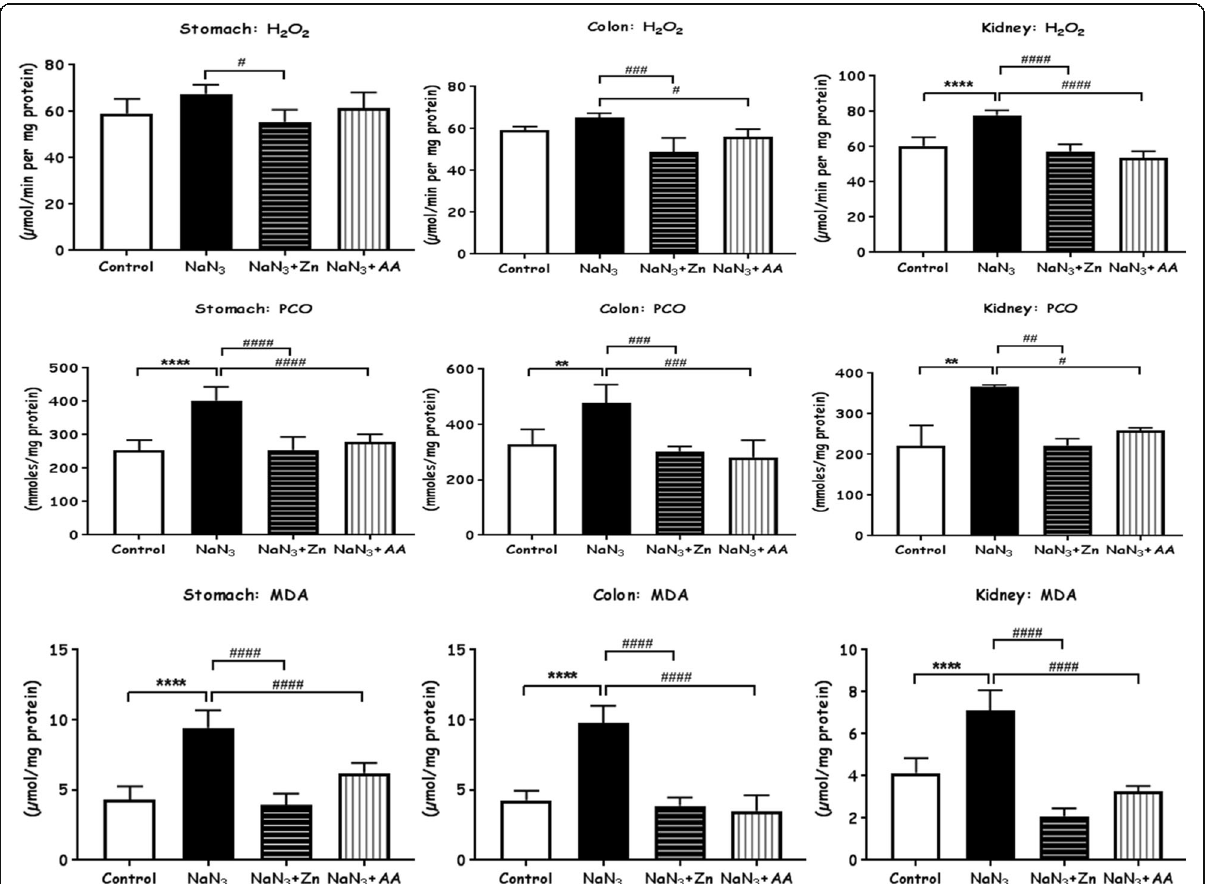
Fig. 2 The effects of Zn sulphate (Zn) and AsA (AA) on hydrogen peroxide (H 2 O 2 ), Protein carbonyl (PCO) and malondialdehyde (MDA) levels in stomach, colon and kidney of rats treated with sodium azide (NaN 3 ). Values are given as mean ± standard deviation ( n = 7). Significant differences: *NaN 3 ; NaN 3 + Zn; NaN 3 + AA versus control group (* p < 0.05; ** p < 0.01; *** p < 0.001; **** p < 0.0001). # NaN 3 + Zn; NaN 3 + AA versus